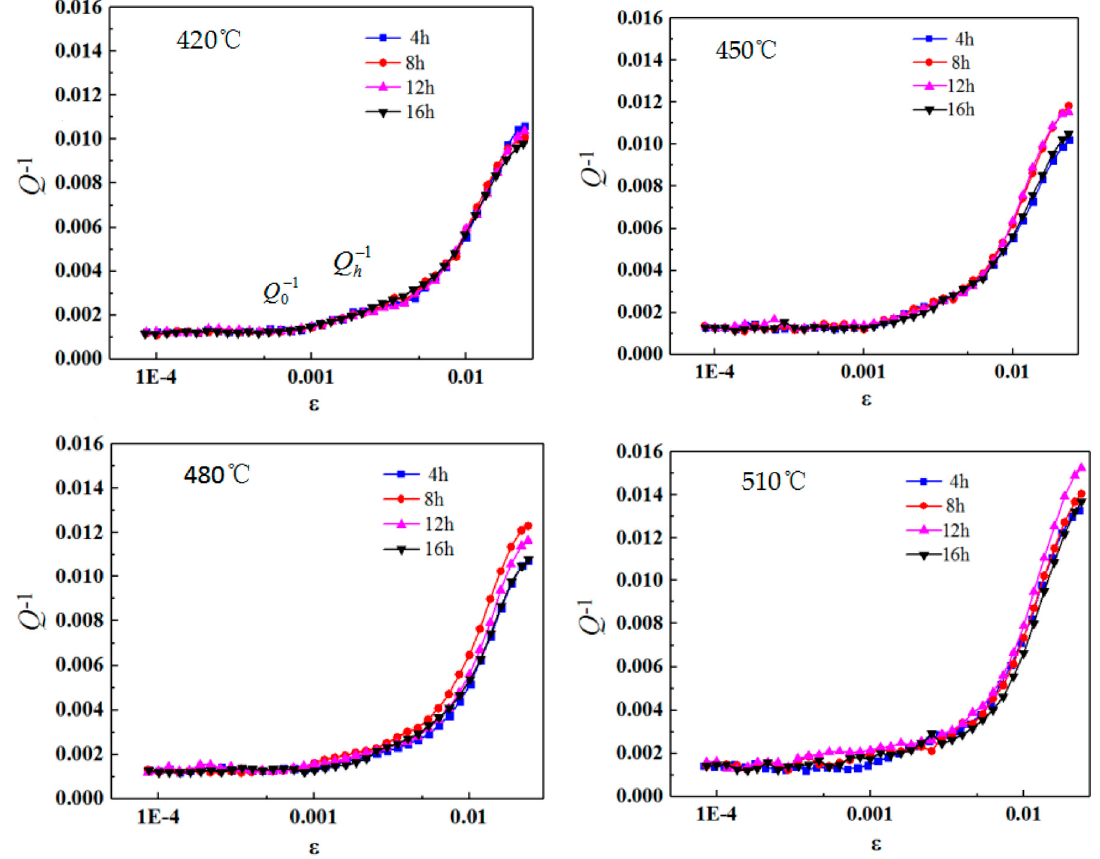
Figure 3. Damping–strain curves after different solid solution treatments.